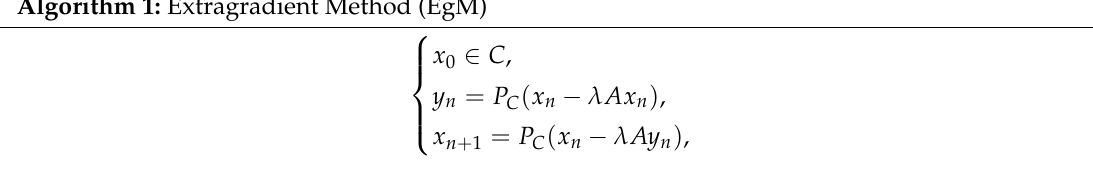
Algorithm 1: Extragradient Method (EgM)